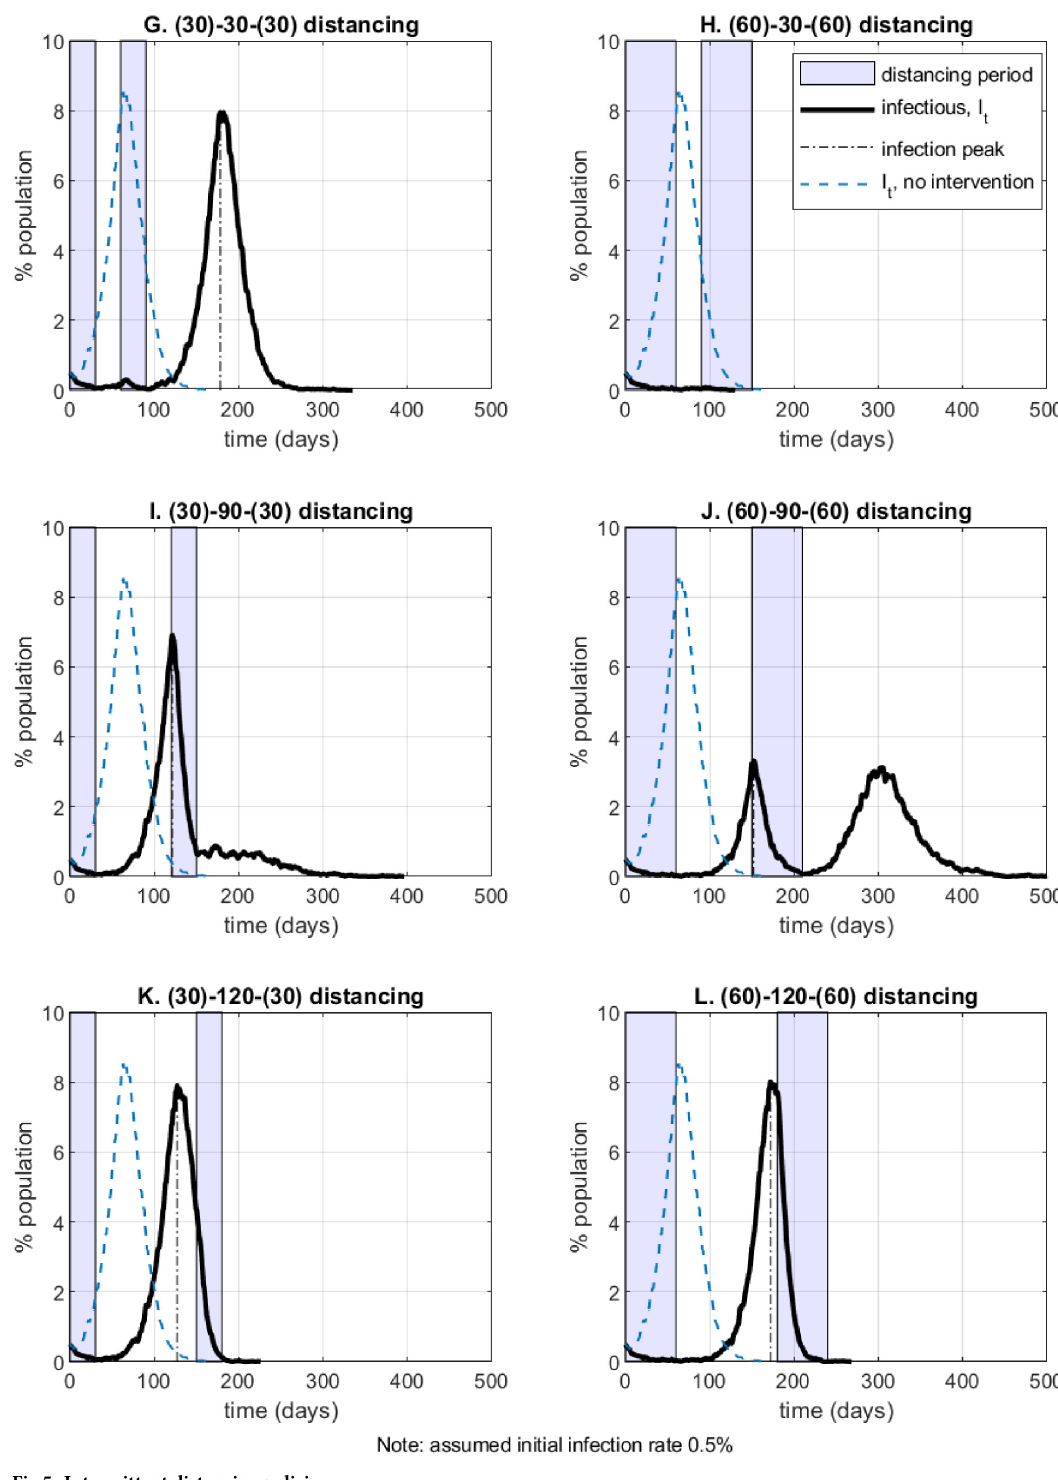
Fig 5. Intermittent distancing